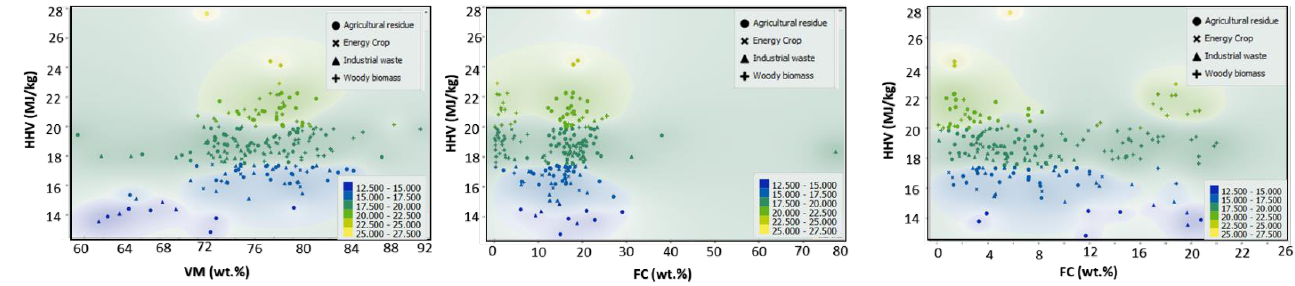
Figure 6. Cross-plots of HHV against the proximate analysis of different biomass classes.